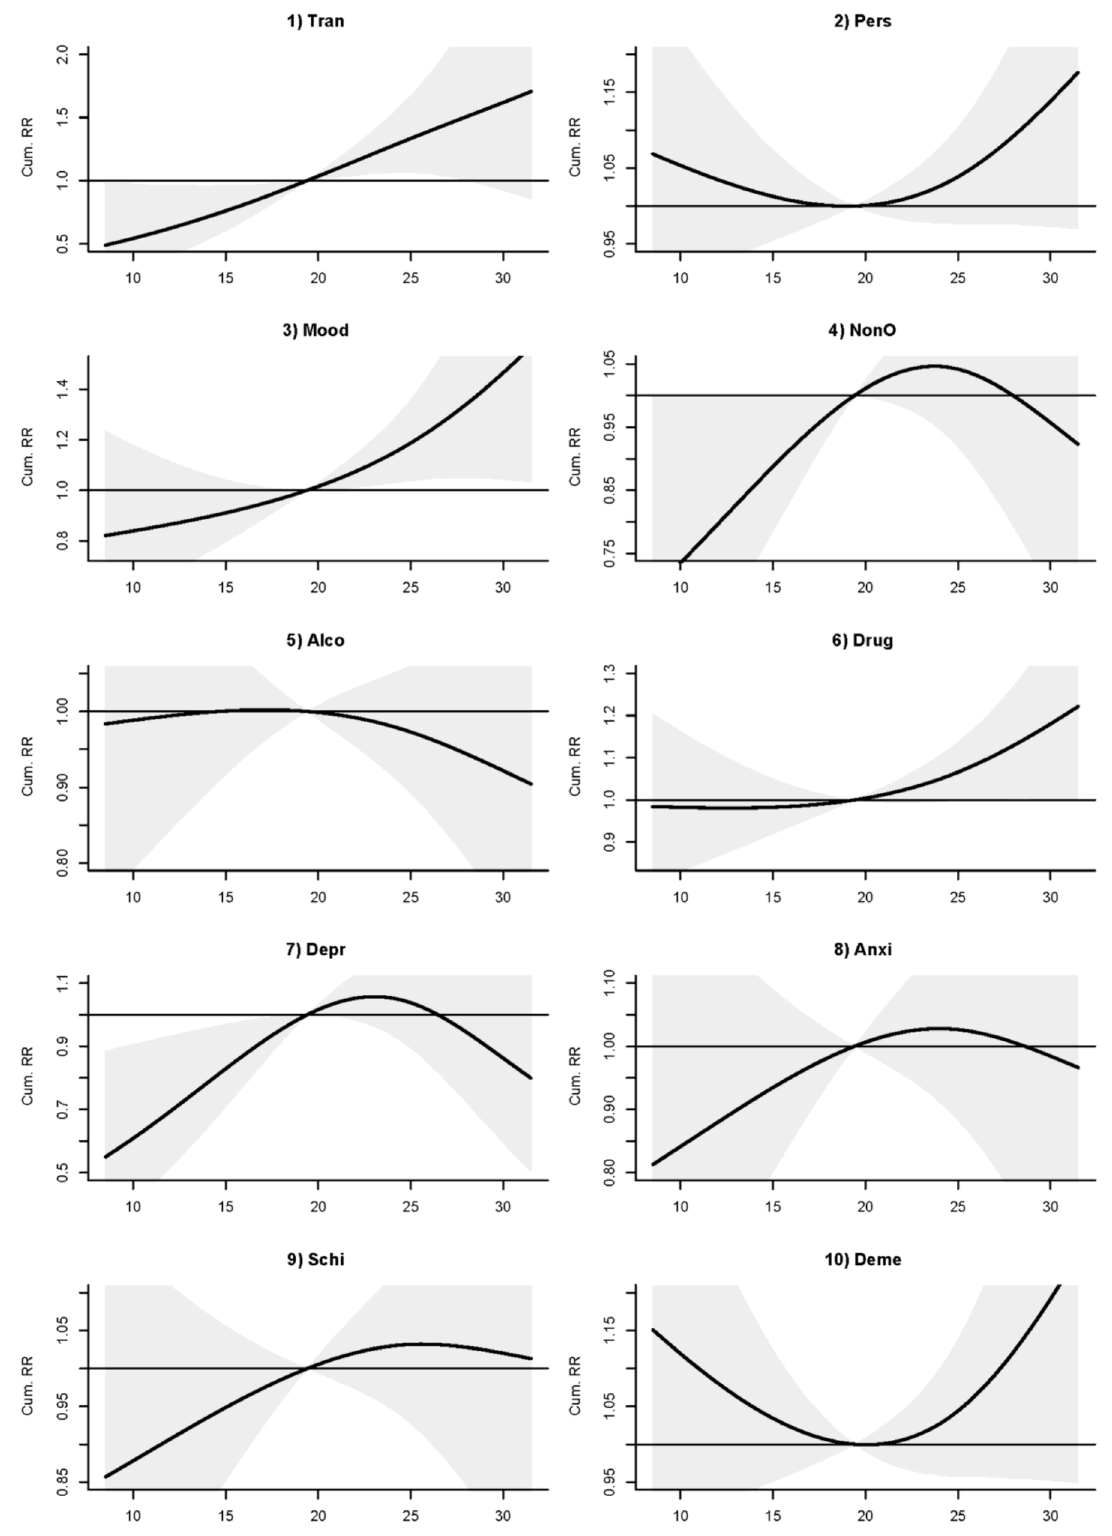
Figure 4. RR-temperature ( ◦ C) plots of mental-disorder (MD) admissions in lagged 0–2 days for ( 1 ) transient mental disorders (Tran), ( 2 ) persistent mental disorders (Pers), ( 3 ) episodic mood disorders (Mood), ( 4 ) other nonorganic psychoses (NonO), ( 5 ) alcohol-related mental disorders (Alco), ( 6 ) drug-related mental disorders (Drug), ( 7 ) depressive disorder (Depr), ( 8 ) anxiety, dissociative and somatoform disorders (Anxi), ( 9 ) schizophrenic disorders (Schi), and ( 10 ) dementias admissions (Deme) in Hong Kong,